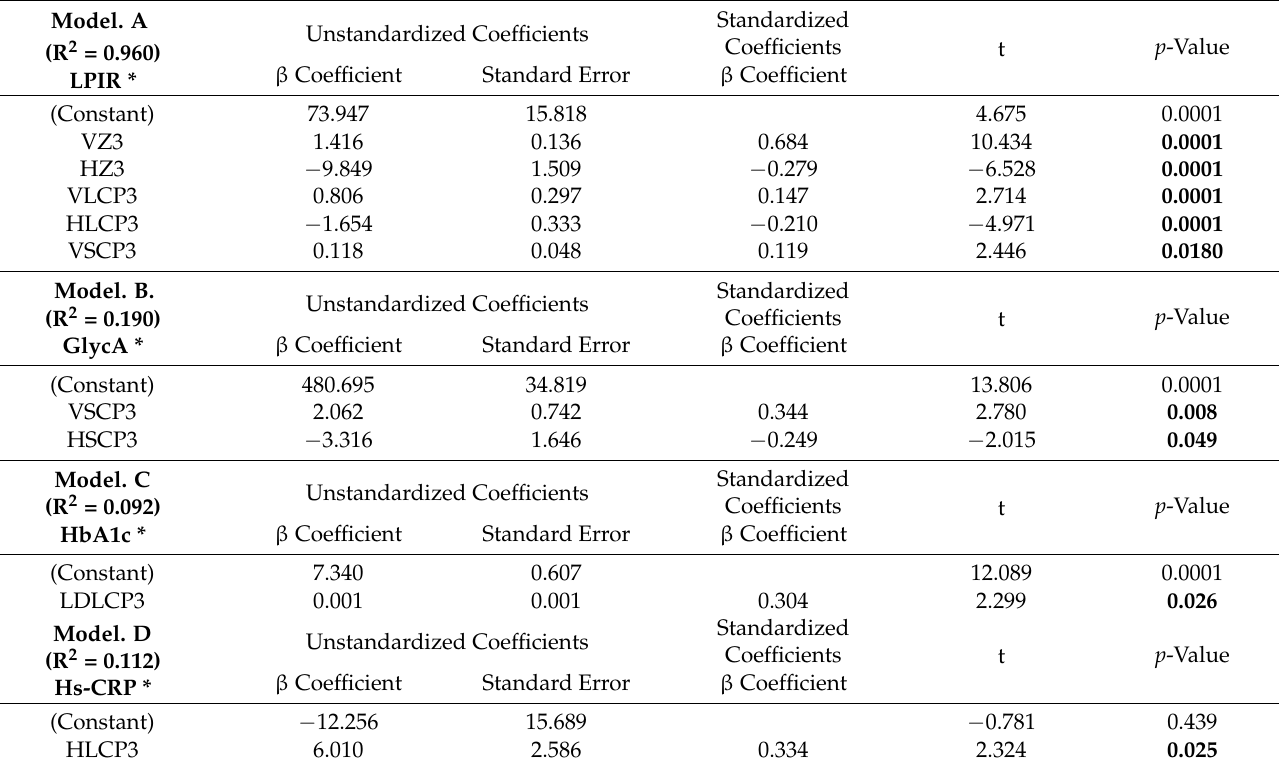
Table 5. Stepwise regression analysis of the association of lipoprotein subpopulations with LPIR, GlycA, HbA1c, and Hs-CRP in T2DM